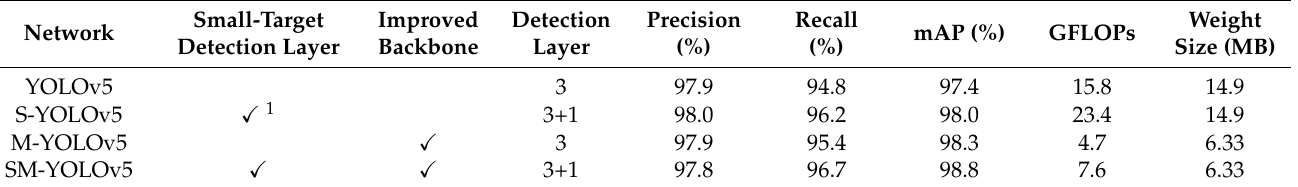
Table 6. Training and validation result comparison between YOLOv5, SSD, YOLOv3, Faster RCNN, and SM-YOLOv5